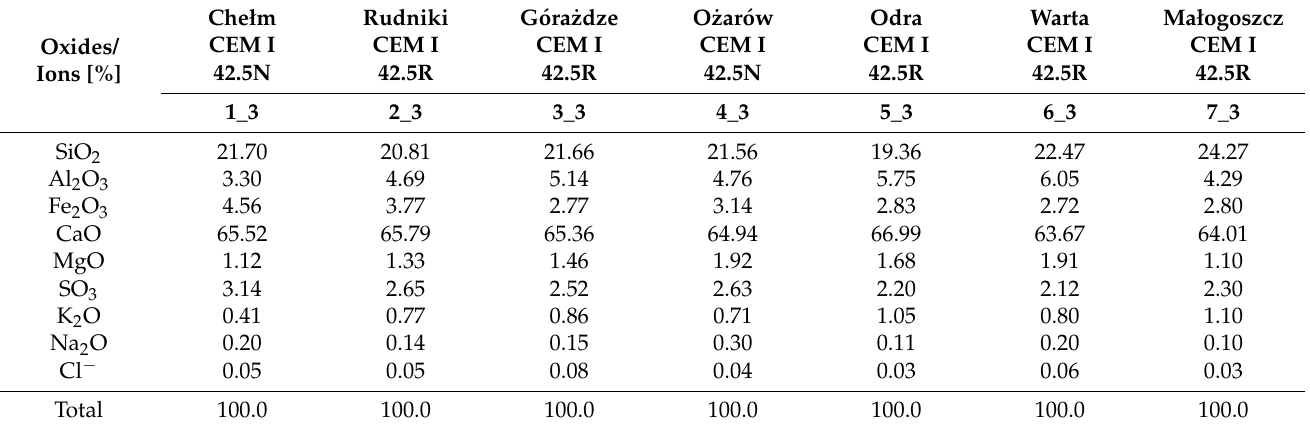
Table 1. Chemical composition of OCP (ordinary Portland